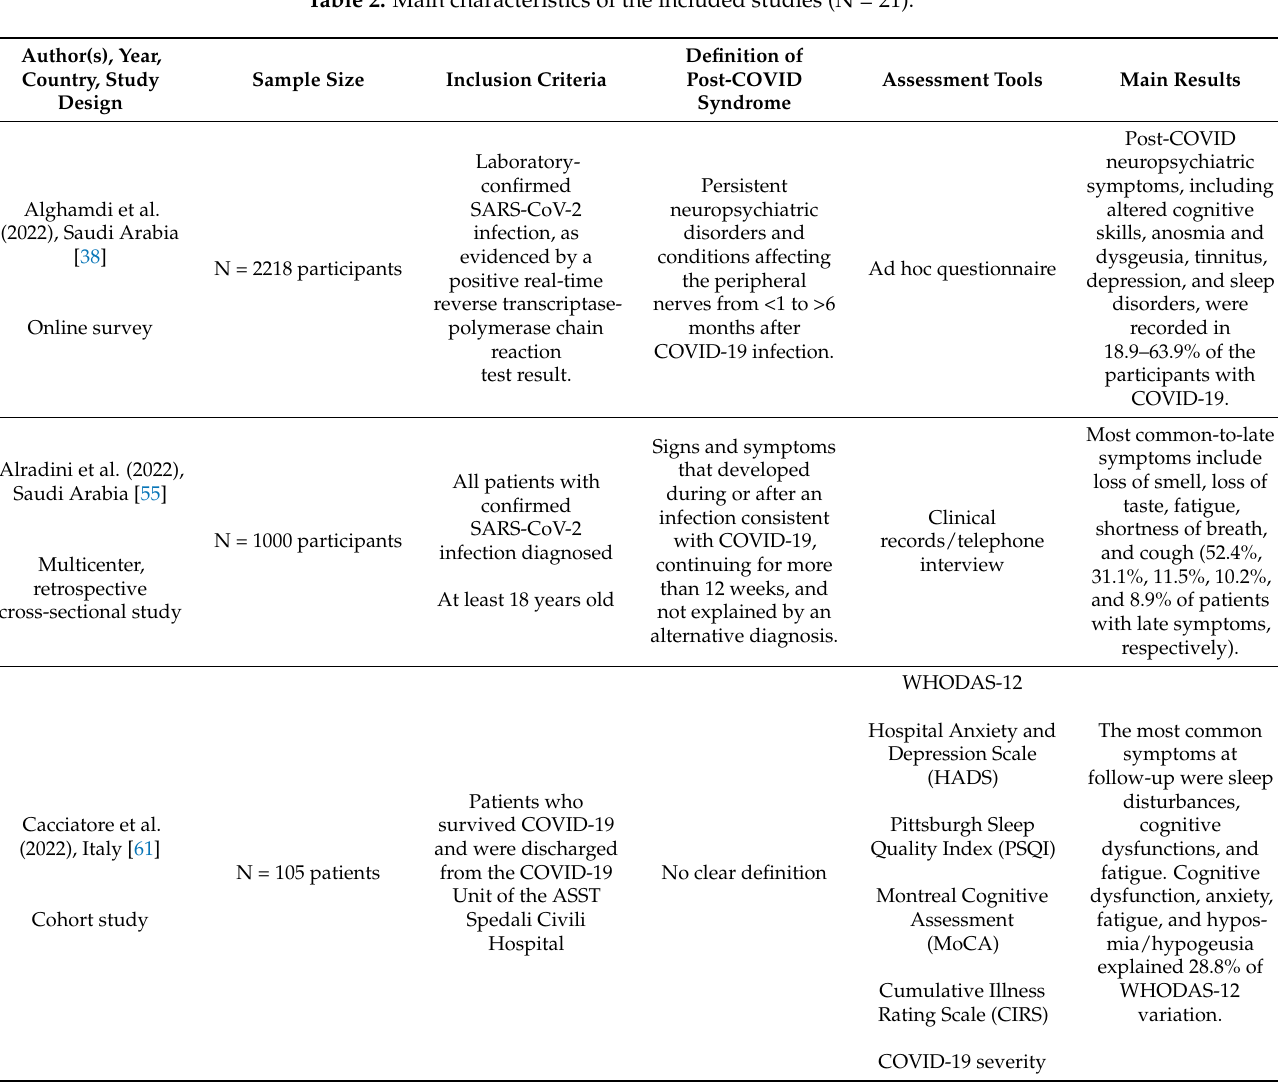
Table 2. Main characteristics of the included studies (N =